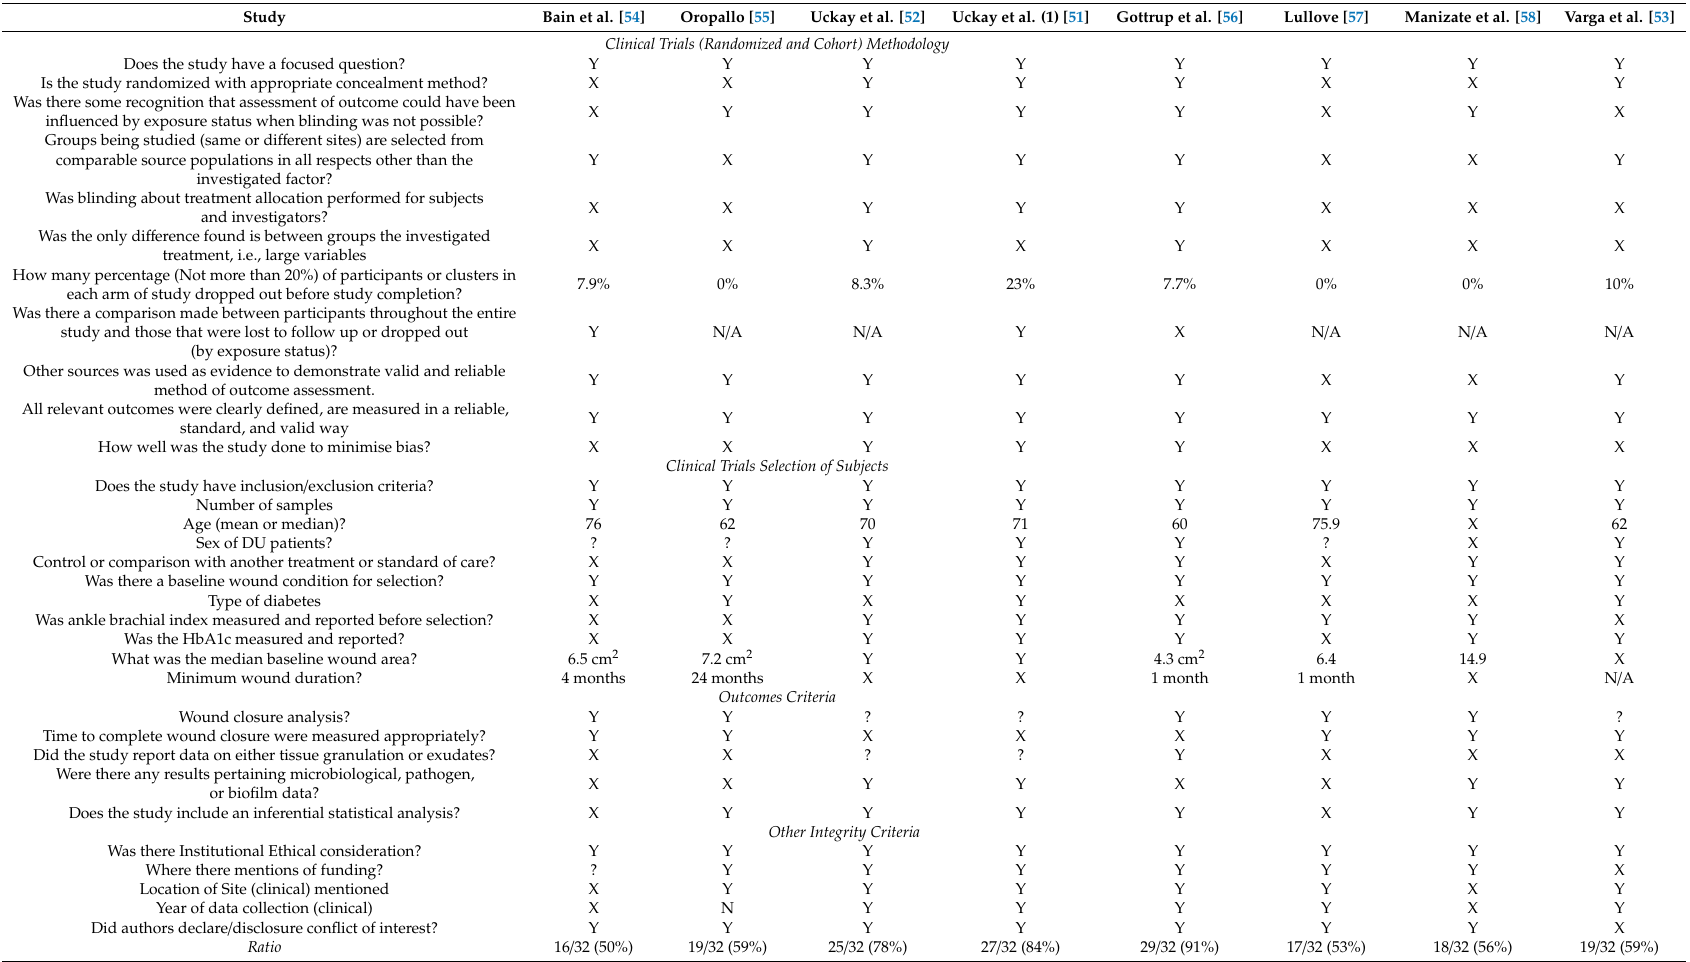
Table 3. Bias criteria of